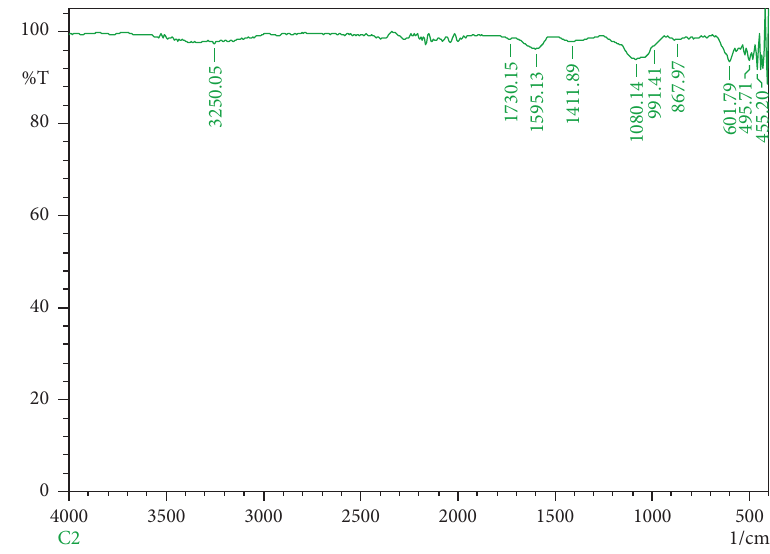
Figure 3: FT-IR spectrum of green-synthesized copper nanoparticles.